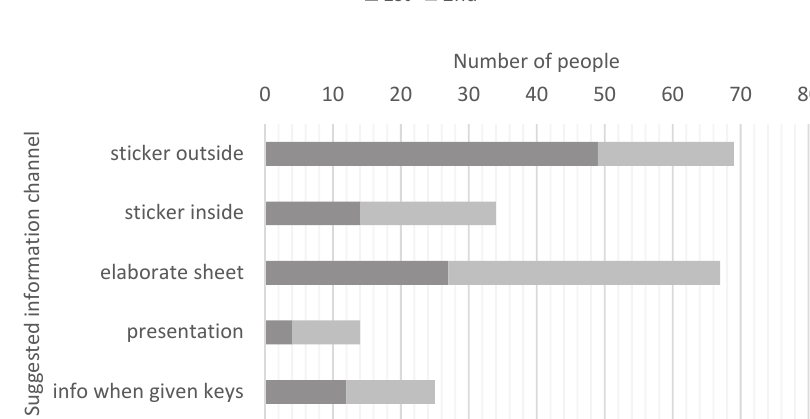
Figure A12. Favorite information channels, first and second choice noted, first survey (106 individuals).